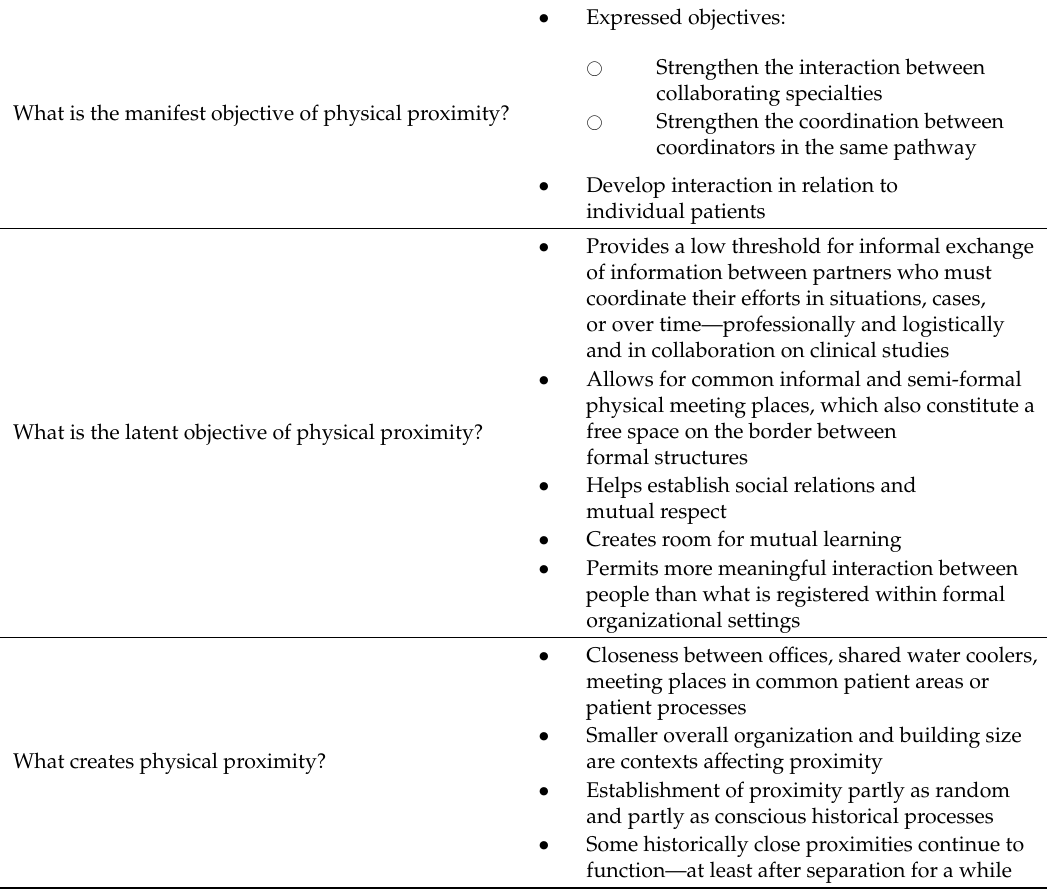
Table 10. Physical proximity as a framework for coordination in patient